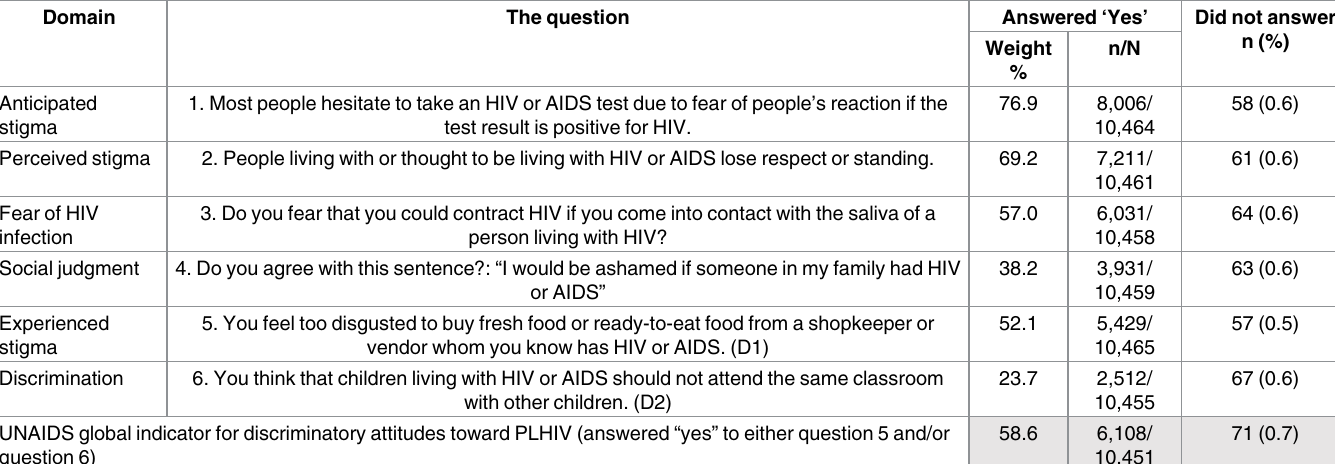
Table 3. Percentage and number of the respondents who had negative attitudes according to particular HIV stigma